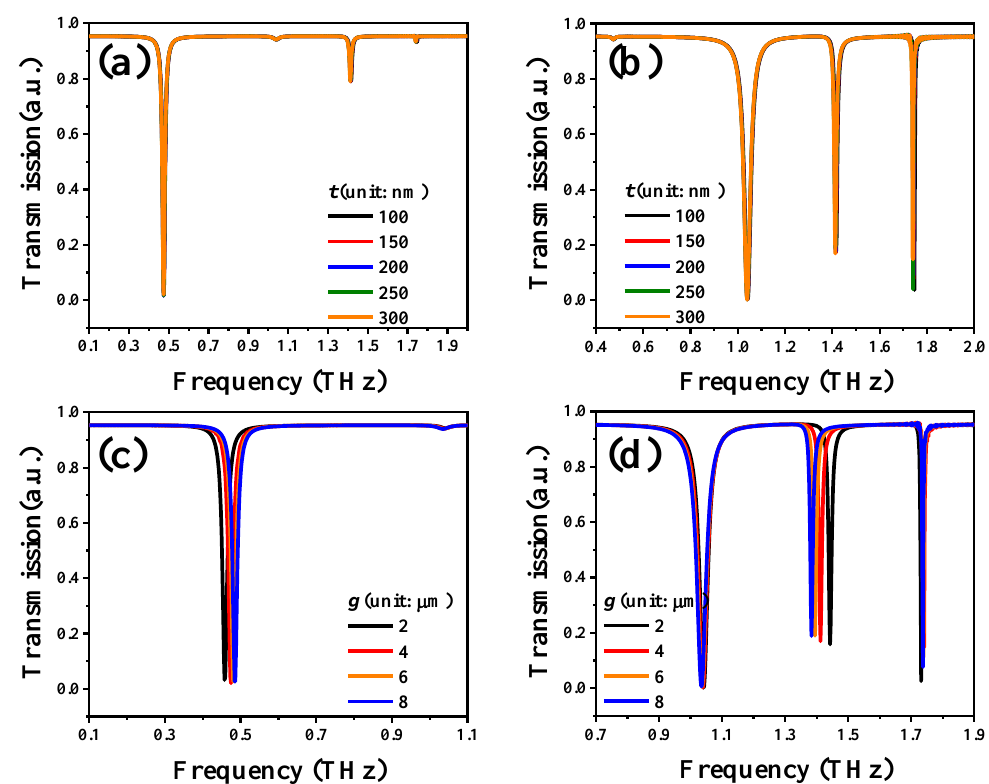
Figure 2. Transmission spectra of SSM with different t values in ( a ) transverse electric (TE)) and ( b ) transverse magnetic (TM) modes. Transmission spectra of SSM with different g values in ( c ) TE and ( d ) TM modes.